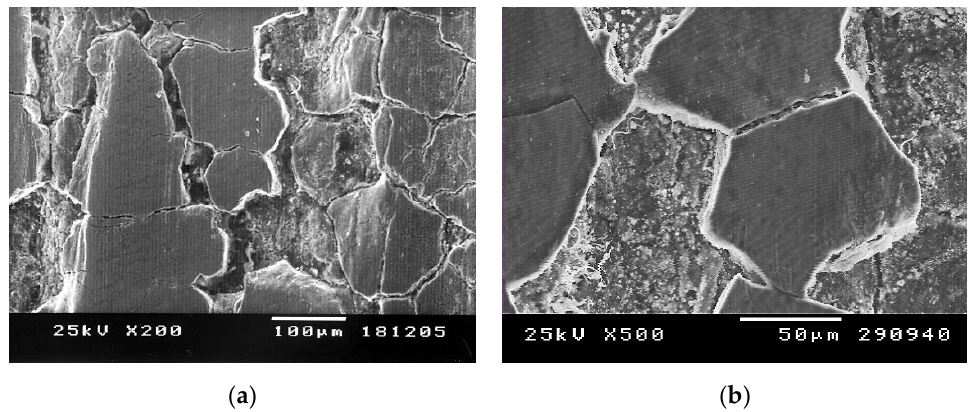
Figure 2. SEM scans of surface structure of chromium layer with visible cracks on the wall of a 30HN2MFA steel barrel (JEOL 5400 scanning electron microscope): ( a ) magnification ×200, ( b ) magnification ×500 [13].